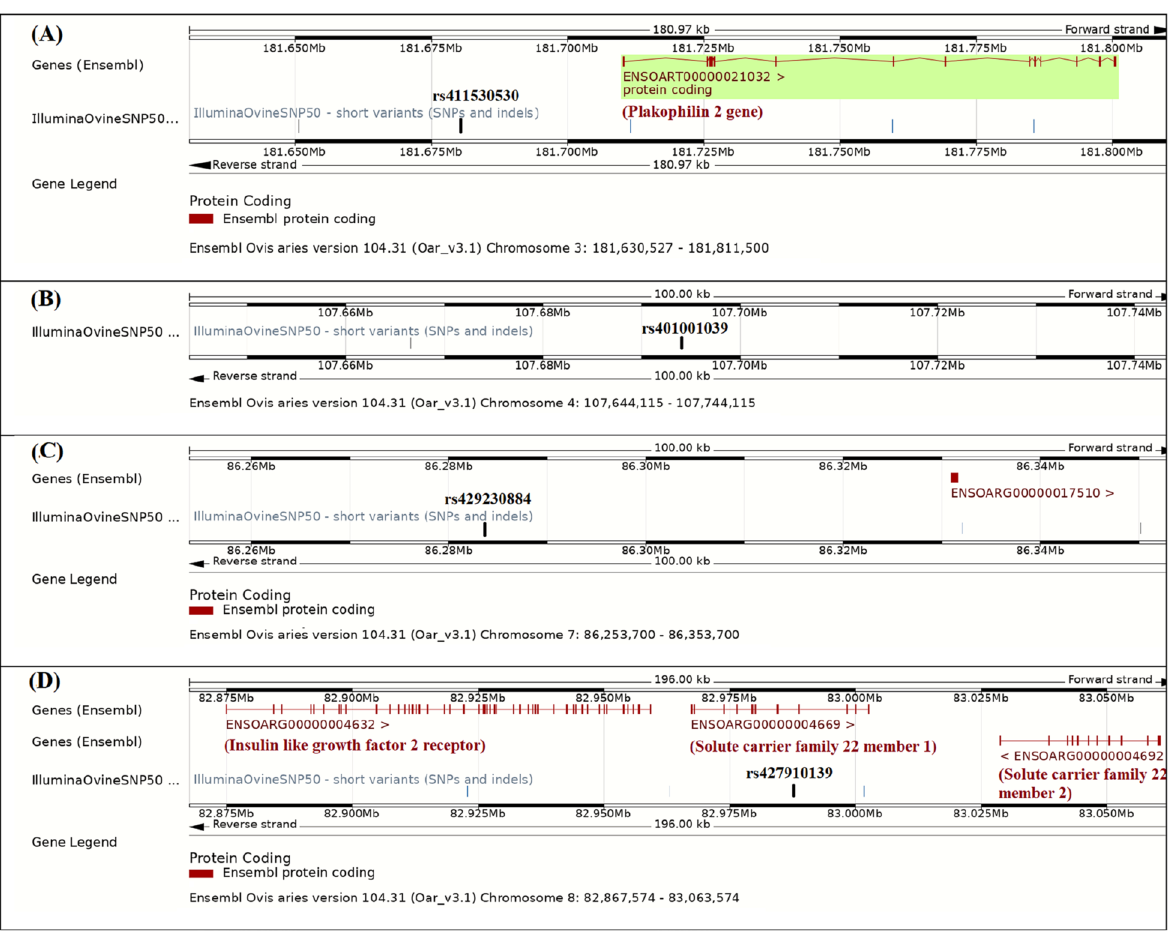
Figure 4. The genes found within 50 kbp distances from the significant SNPs on chromosomes 3 ( A ), 4 ( B ), 7 ( C ) and 8 ( D ), based on BioMart tool of Ensembl (www. ensem bl.